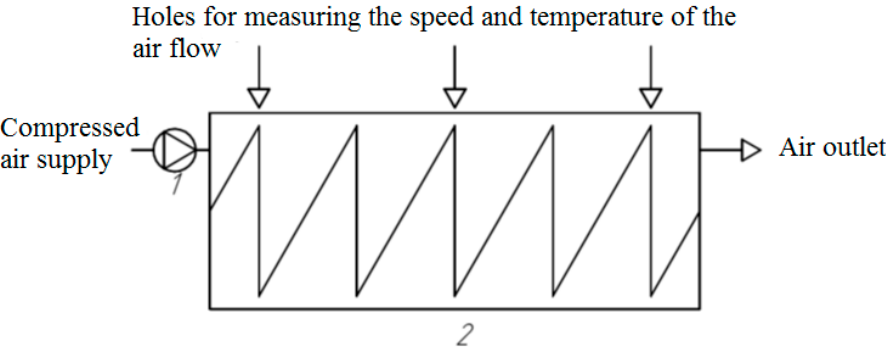
Figure 5. Diagram of the aerodynamic system of the laboratory stand: 1—fan; and 2—cylinder with a coil.